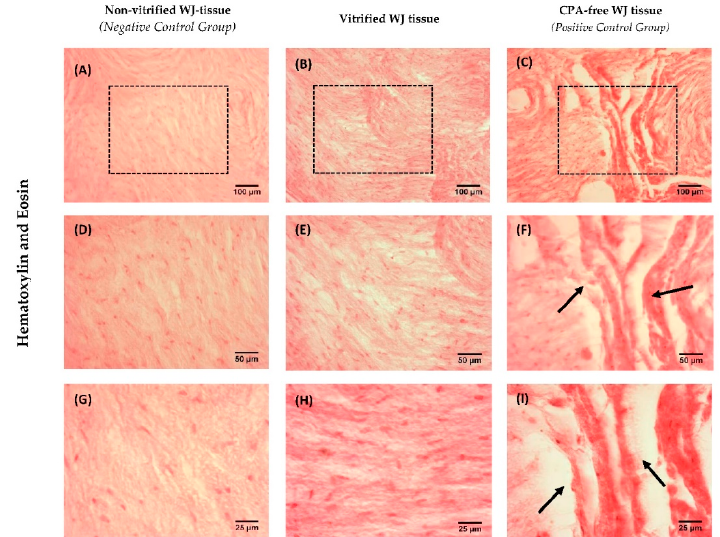
Figure 2. Histological analysis of WJ tissue. Non-vitrified (n = 5) WJ tissue ( A , D , G ), vitrified (n = 5) WJ tissue ( B , E , H ) and CPA-free (n = 5) WJ tissue ( C , F , I ) stained with H&E. The black boxes in 10× images ( A – C ) highlights the region that appeared in higher magnification of 20× and 40×. Black arrows in CPA-free WJ tissue with magnification 20× and 40× indicated the extensive damage of the tissue. Images A - C , were acquired with original magnification 10×, scale bars 100 μ m. Images D – F , were acquired with original magnification 20×, scale bars 50 μ m. Images G – I , were acquired with original magnification 40×, scale bars 25 μ m.